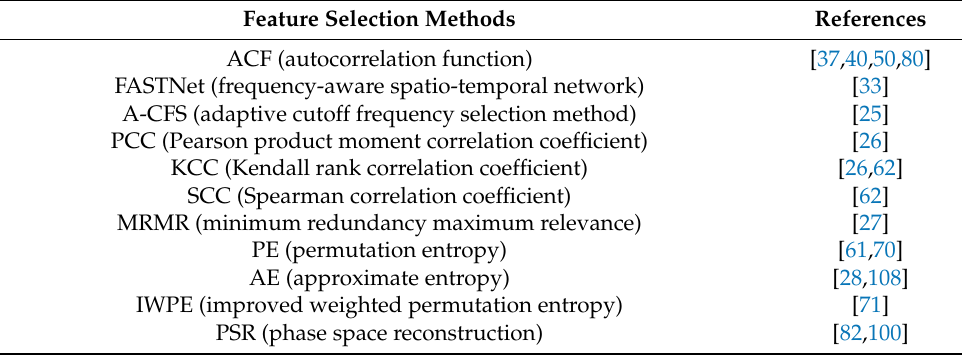
Table 2. Summary of adopted feature selection